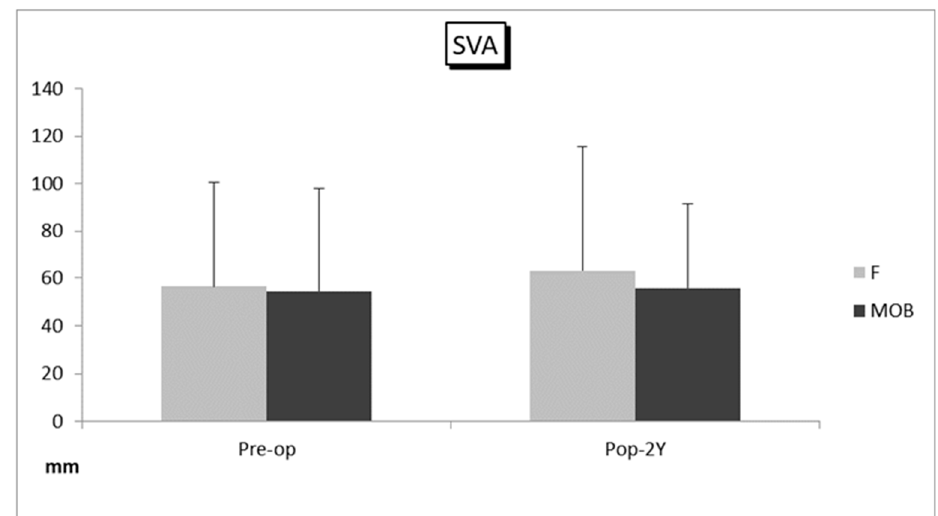
Figure 1. Angle of lumbar lordosis (LL) in the MOB patient group (MOB group) and the first surgical patient group (F group). The bars depict preoperative and follow-up average values and standard deviations in each group. Abbreviations: Pre-op, before surgery; Pop-2Y, at 2 years after surgery.